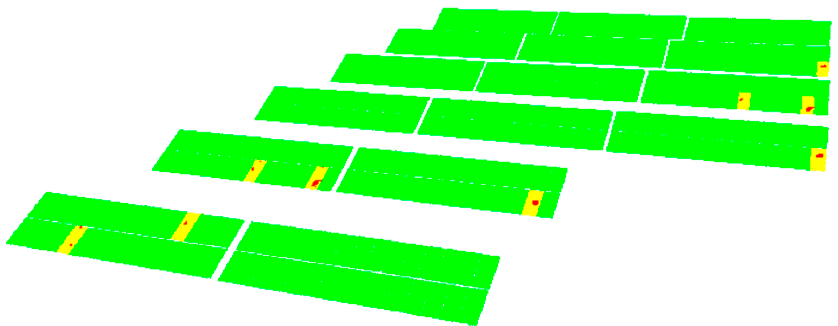
Figure 9. Result of the temperature-based detection of thermal pathologies applied to each single PV panel: (Green) Non-Damaged PV panels; (Yellow) Damaged PV panel; and (Red) Damaged surface. Table 5. Damaged PV panel parameters: IDs are defined in ascendant order from north to south and from west to east.